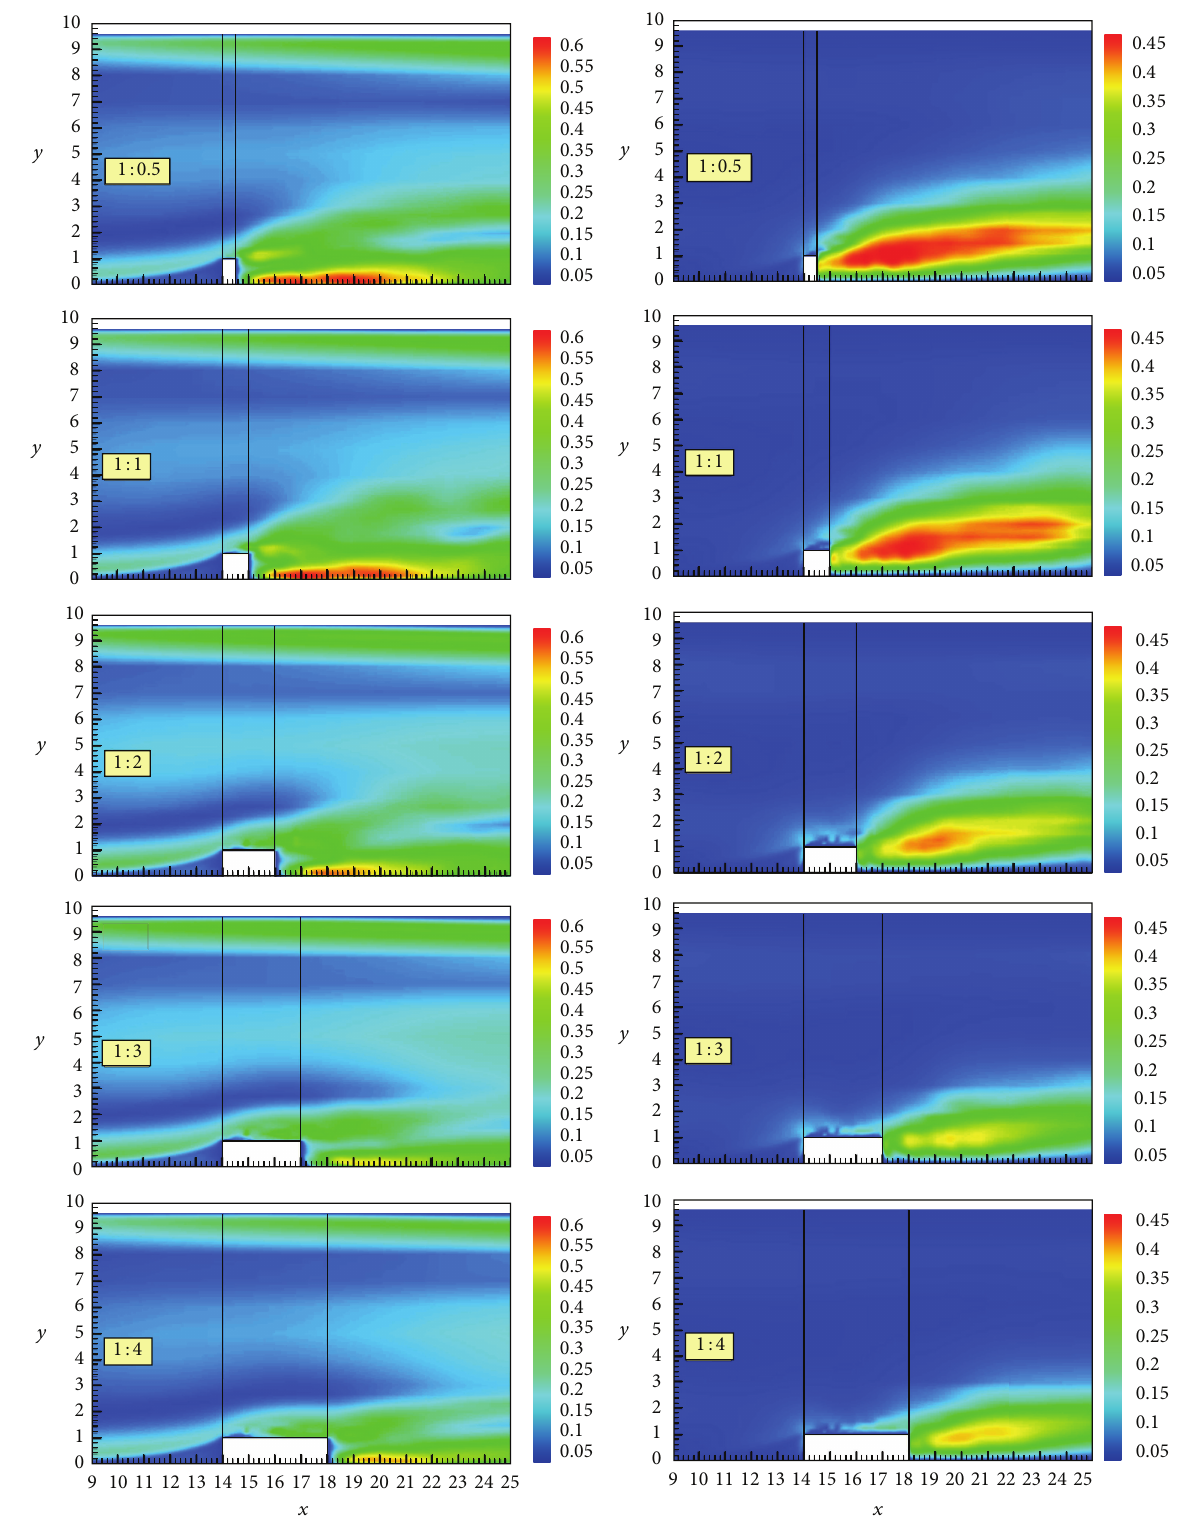
Figure 7: Color-coded plots of streamwise (a) and transverse (b) turbulent